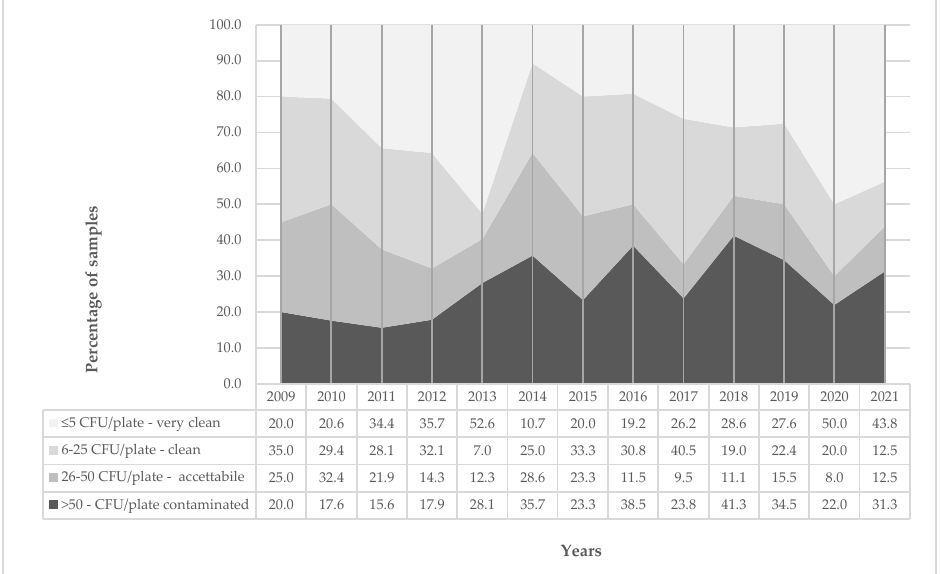
Figure 2. Distribution (%) of surface samples by level of contamination over years (2009 – 2021).